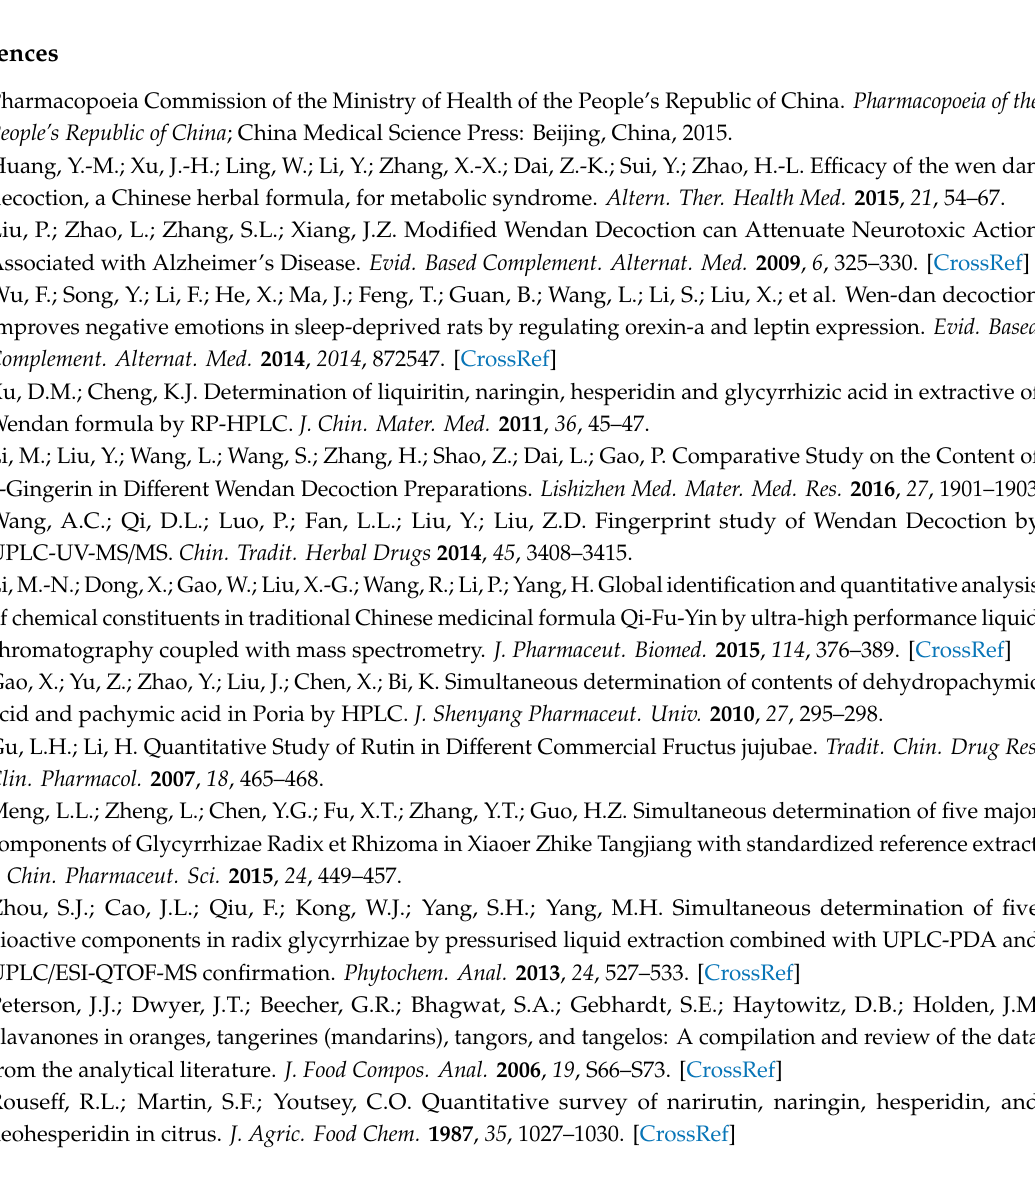
chemicals. Figure S2: The characteristic product ion maps of the 19 chemicals. Figure S3: The four decoction pots in the WDD extraction process. Figure S4: Pinelliae Rhizoma (A), Bambusae Caulis in Taenias (B), Aurantii Fructus Immaturus (C), Citri Reticulatae Pericarpium (D), Glycyrrhizae Radix Et Rhizoma (E), Poria (F), Zingiberis Rhizoma (G) and Jujubae Fructus (H). Table S1: Chemicals contents in a daily dose of WDD prepared in the lab and its five brands commercial preparations ( µ g). Table S2: The proportion of the herbs and the excipiet in a daily dose of the WDD preparations. Table S3: The “total daily dosages of measured ingredient” for the 7 seven pieces of traditional Chinese